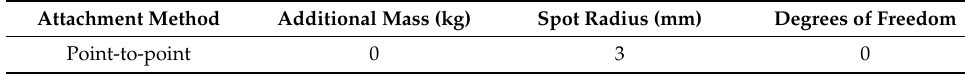
Figure 2. Center pillar and PW: ( a ) geometry and mesh; ( b ) weld constraints. Table 2. Spot weld conditions for FE simulation. Table 2. Spot weld conditions for FE